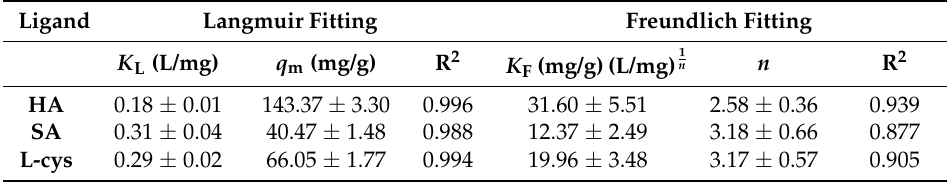
Table 3. Langmuir and Freundlich fitting for HA, SA and L-cys adsorption on ZnO NPs.